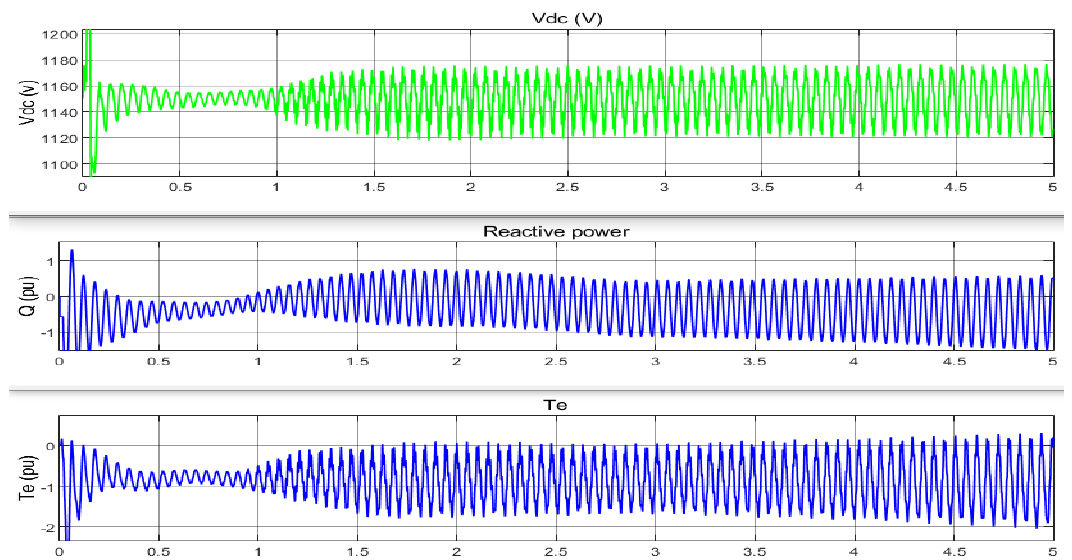
Figure 14. Capacitor voltage, reactive power, and electrical torque in k = 75%&, v = 7 m/s with FLWADC. Ignored latency in time delay equal 500 𝑚𝑠 .